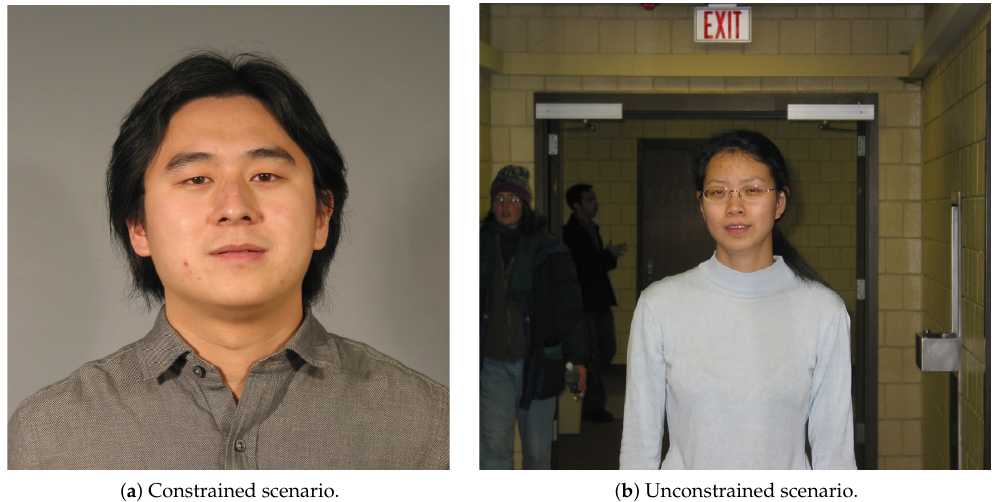
Figure 3. Example of FRGC face images. Source: